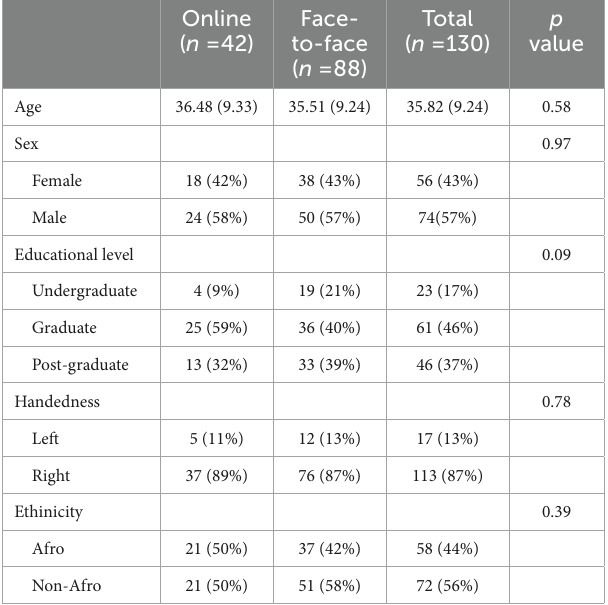
TABLE 1 Demographic characteristics of American participants according to the test modality (online vs. face-to-face).